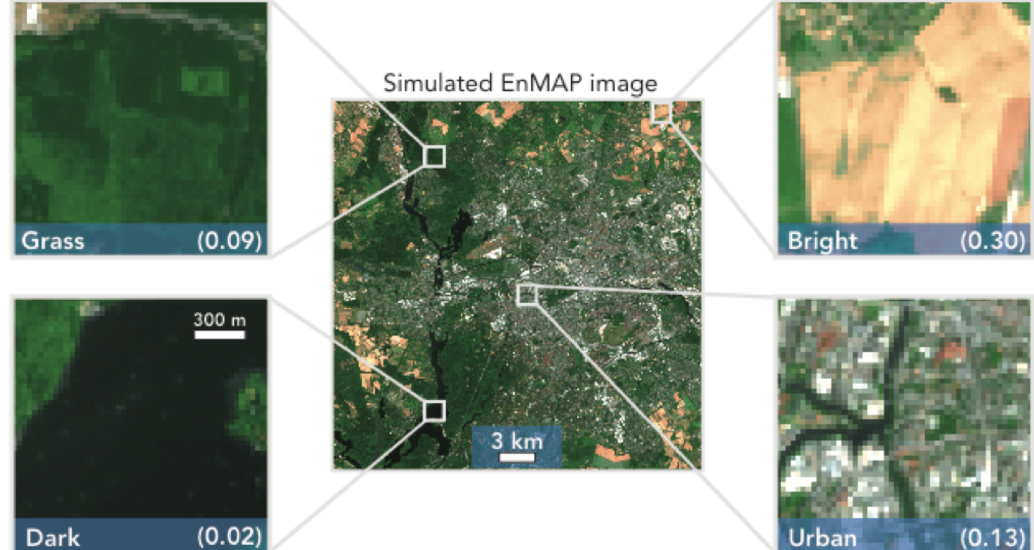
Figure 2. RGB image of a synthetic EnMAP scene simulated using the EnMAP end-to-end simulation tool (EeteS) over Berlin. Four scenes with 30m × 30m pixel resolution are shown (grass, dark, bright, urban) with average surface reflectances in the SWIR (2210–2410nm) given in parentheses. These different scenes are used in Sect. 3 to evaluate the ability of EnMAP to retrieve atmospheric methane plumes.